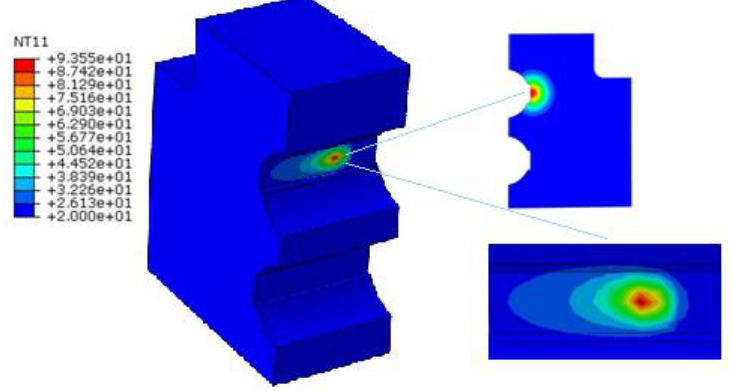
Figure 4. Laser quenching temperature field distribution of pitch bearing raceway.